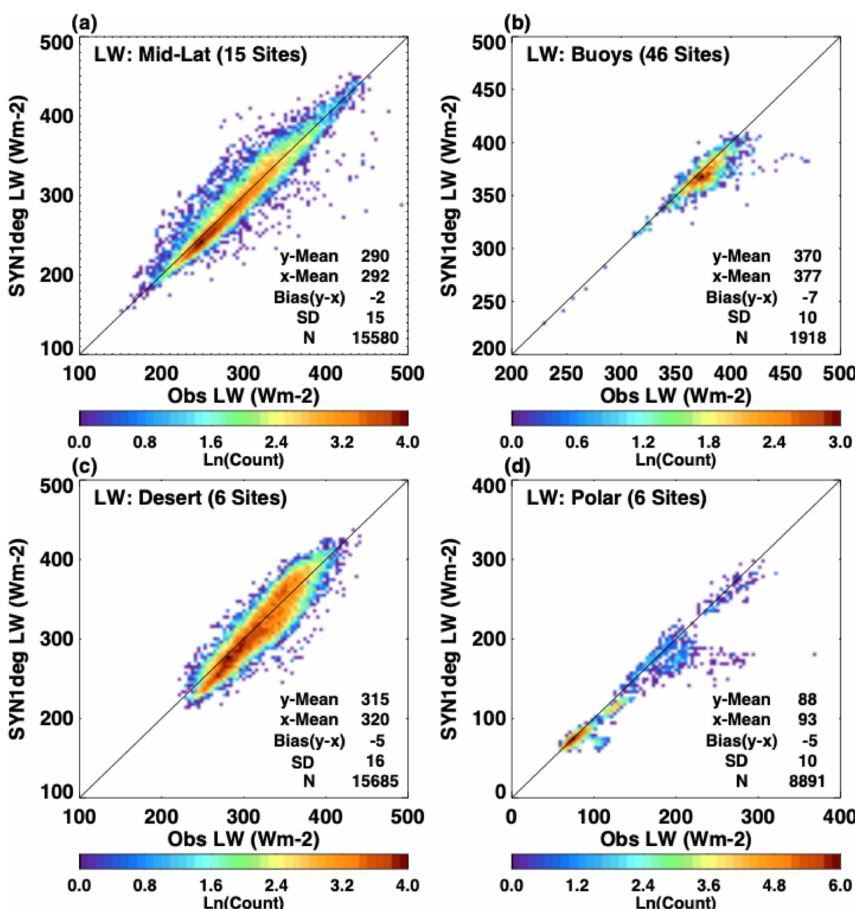
Figure 14. Comparisons of longwave downward irradiance at the surface from the SYN1deg Edition 4.1 calculations ( y axis for all plots) and BSRN and buoy surface sites ( x axis all plots). Data are from March 2000 through February 2020 and only include hours when a 1 ◦ × 1 ◦ grid box is 100% clear sky according to the SYN1deg cloud fraction.